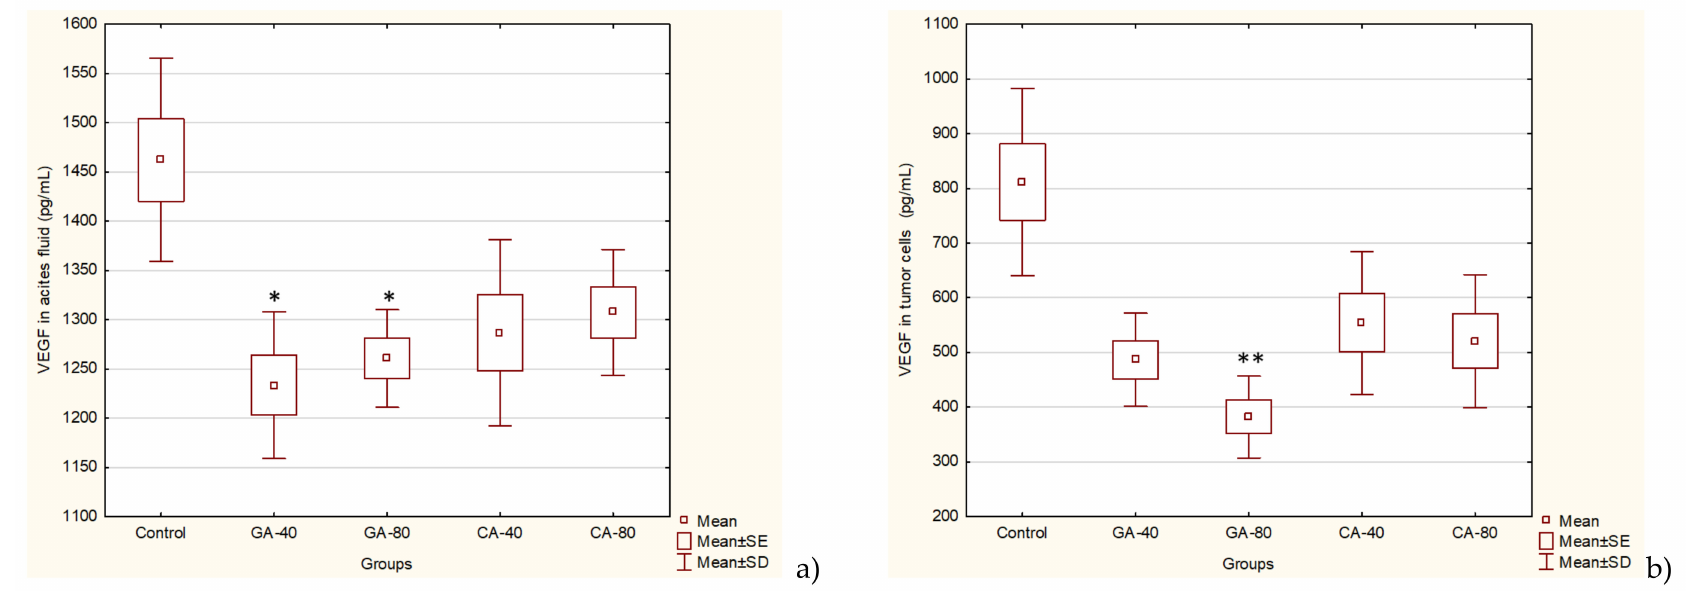
Figure 4. E ff ect of GA and CA on proangiogenic vascular endothelial growth factor (VEGF) in ascites fluid ( a ) and tumor cells ( b ) of mice bearing EAT. Mice were injected intraperitoneally ( ip ) with 2.5 × 10 6 viable EAT cells and treated with GA or CA at a dose of 40 mg / kg and 80 mg / kg ip in exponential tumor growth phase on days 5, 7, 9, and 11. Mice were sacrificed on the 13th day, ascitic fluid and tumor cells were collected, and the VEGF levels were estimated by ELISA. The results are expressed as the mean value of each experimental group ± SE of the mean of three di ff erent observations; * p < 0.05, ** p < 0.01 as compared to the control group treated with saline. Abbreviations: EAT, Ehrlich ascites tumor; GA, gallic acid; CA, ca ff eic